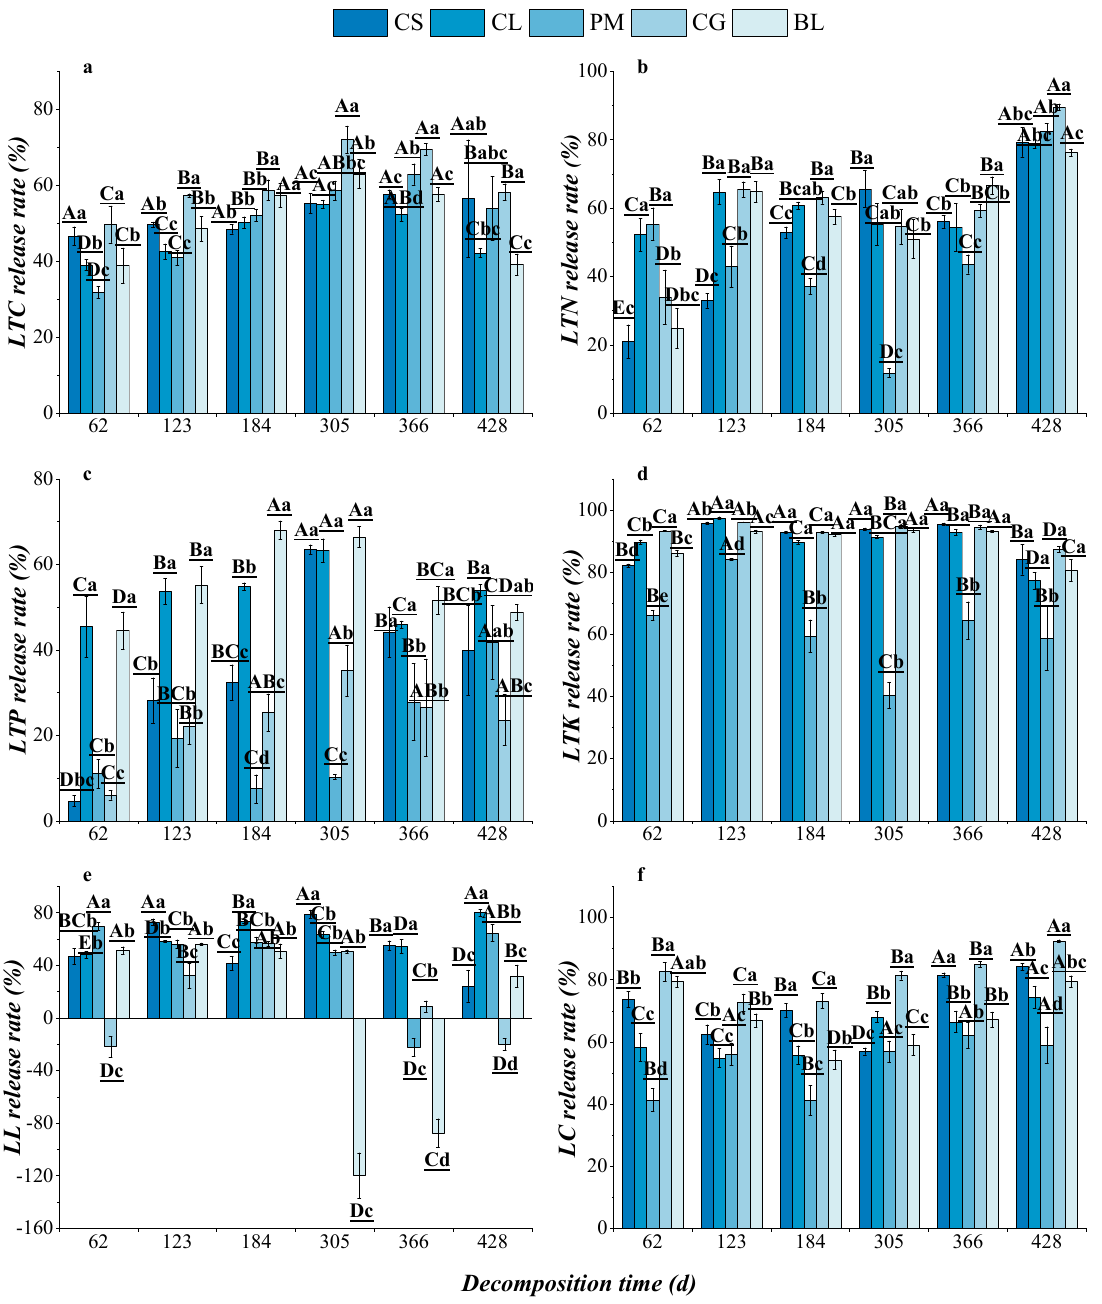
Figure 5. Nutrient release rate of different litters during the litter decomposition process. CS— Ca-